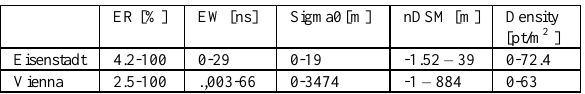
Table 1. The range of ER, EW, Sigma0 , nDSM, Density for Eisenstadt and Vienna.